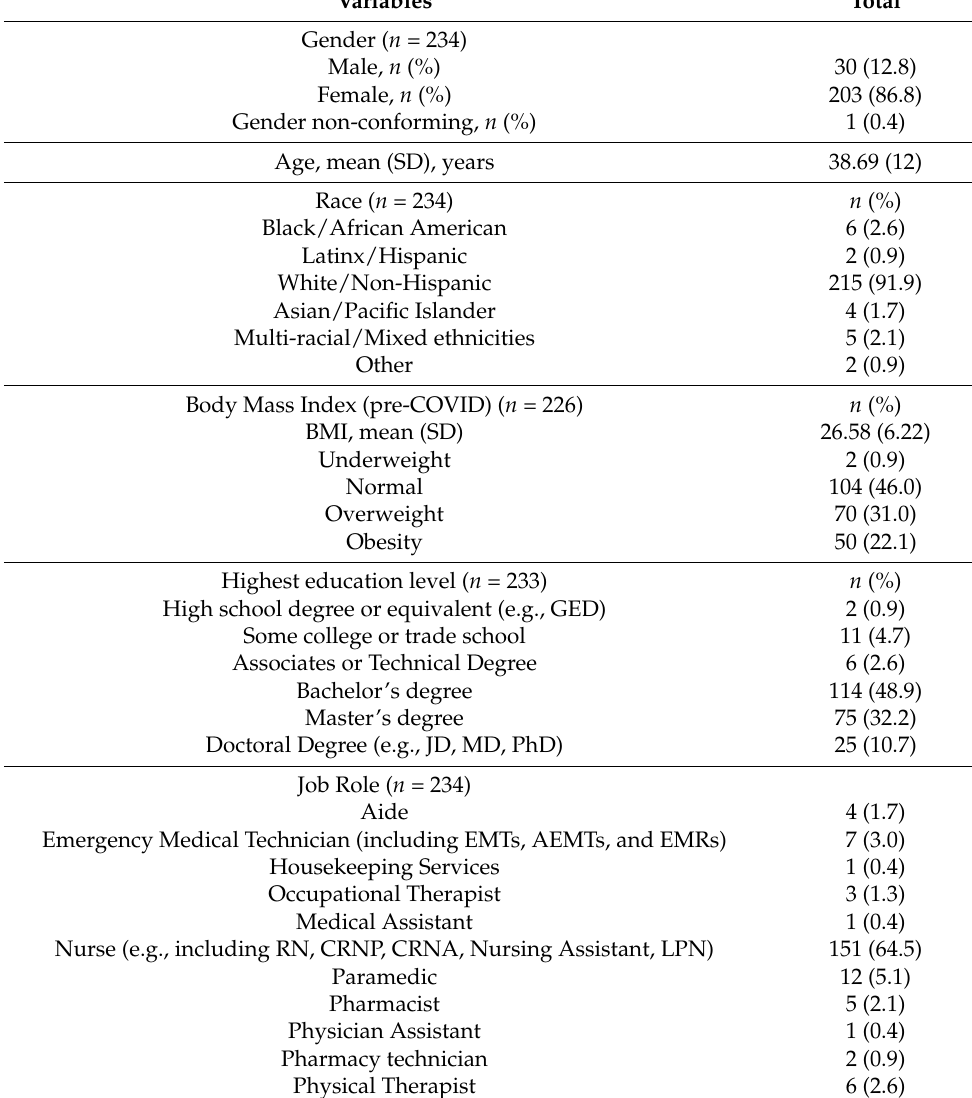
Table A1. Demographic characteristics of HCW participants at baseline (M0) ( n =